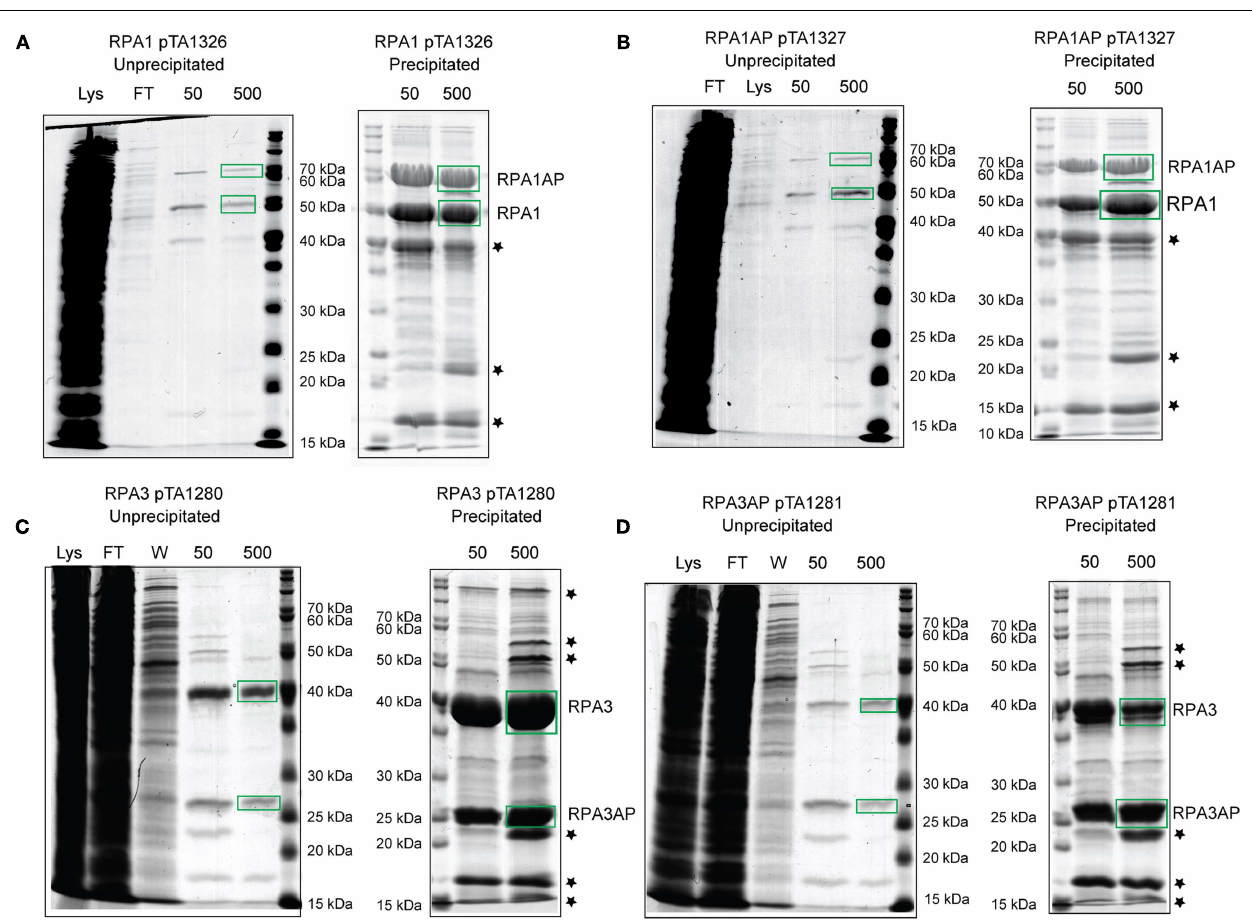
chelating column, samples were taken from the flow-through (FT) and bound proteins were eluted using 50 and 500mM imidazole. Precipitation using trichloroacetic acid and deoxycholate was used to enhance visualization and identification of the eluted proteins by mass spectrometry. Stars denote contaminants shown in Figure 5D